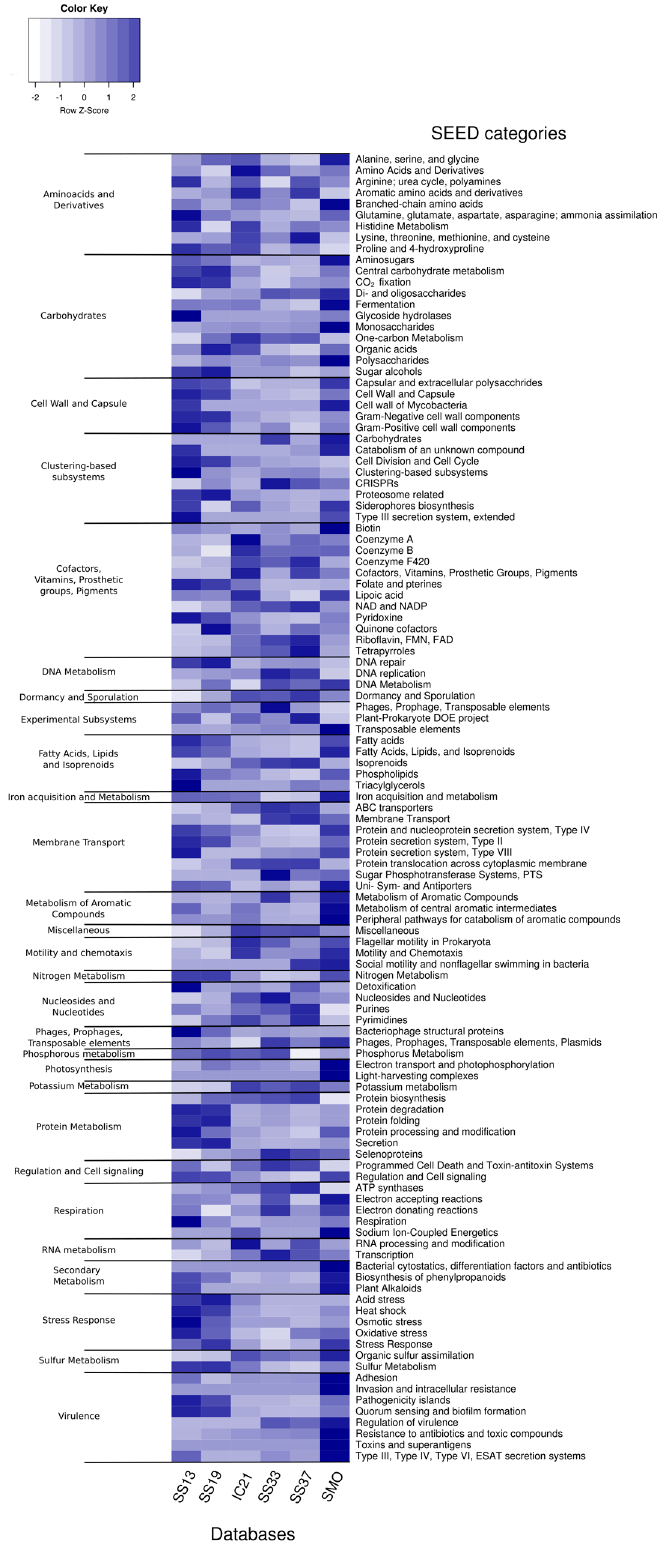
Figure 4. Heatmap depicting the proportion of proteins related to SEED subsystems in the salterns and soil databases. Salterns databases used are described in Table 1. SMO refers to the contigs resulting from the co-assembly of the two saline soil databases, SMO1 and SMO2. Scale has been applied by row.